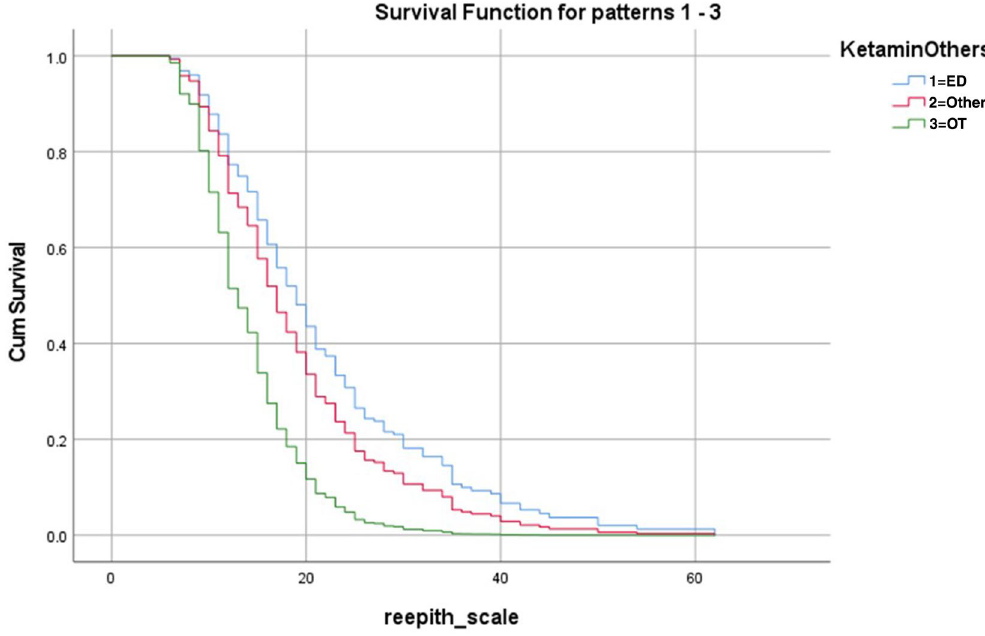
Figure 1. Effect of non-excisional debridement on re-epithelialisation time (Cox survival Plot).